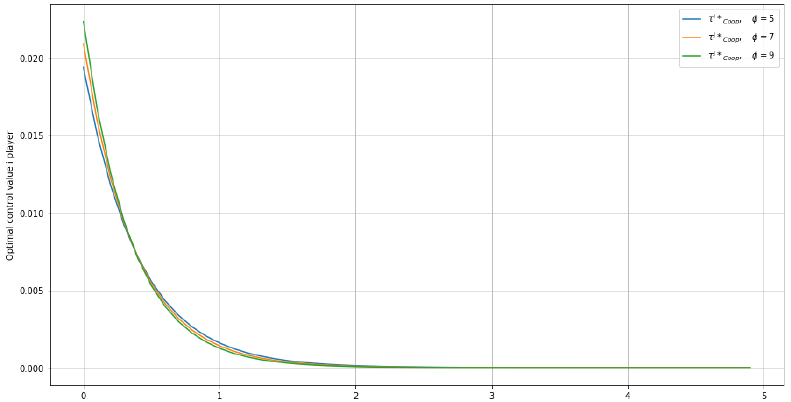
Figure 10. The optimal controls of player i under cooperative scenario and different φ .